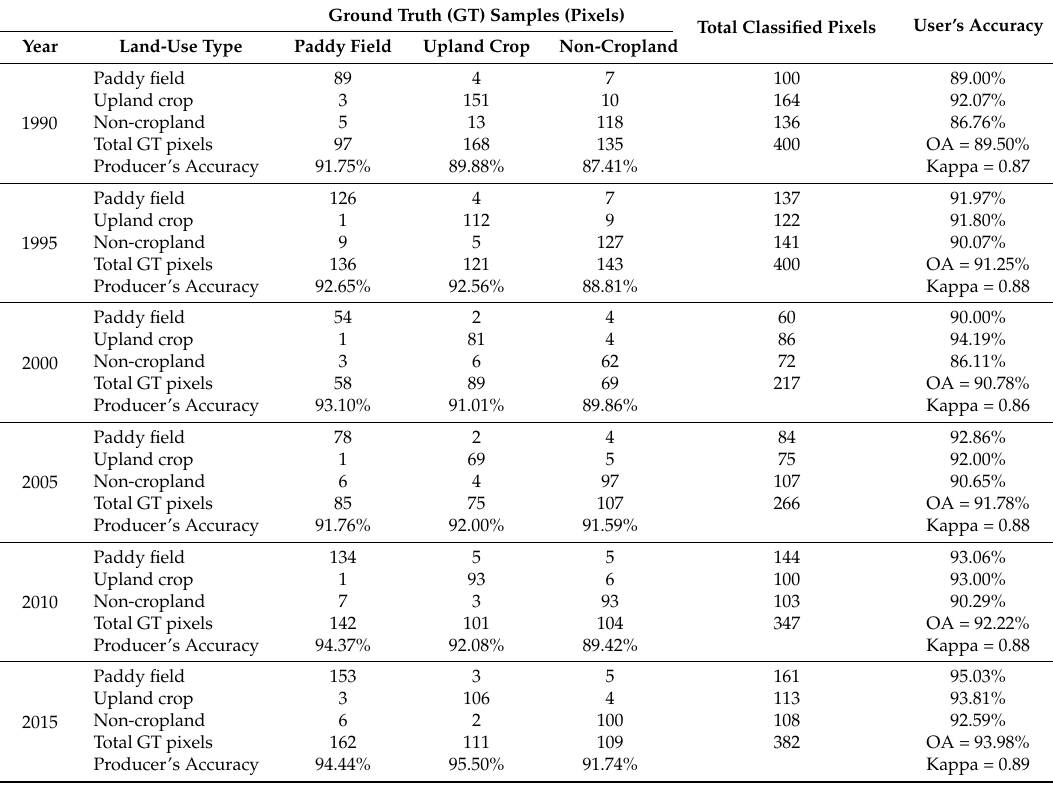
Table 4. Confusion matrix of land-use validation based on Landsat TM and Google Earth imagery in the special epochs of 1990, 1995, 2000, 2005, 2010, and 2015. The overall accuracy (OA), user accuracy, producer accuracy, and kappa coefficients are also